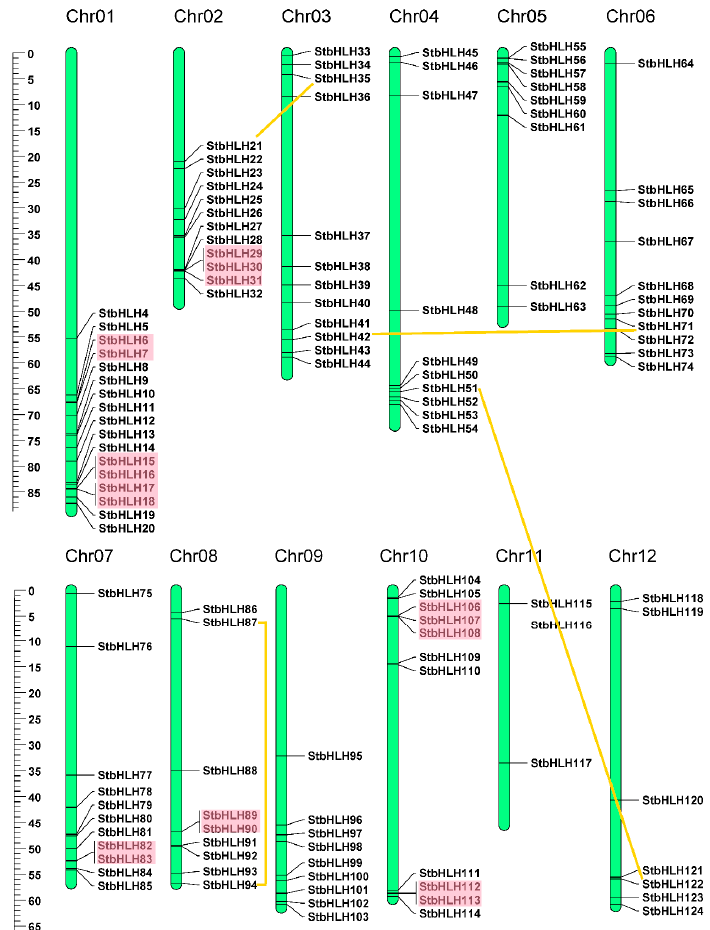
Figure 3. Chromosomal distribution and gene duplications of StbHLHs . The tandem duplicated genes are represented by red rectangles, and the segmental duplicated genes are linked by orange lines. The scale bar on the left indicated the length (Mb) of potato chromosomes.